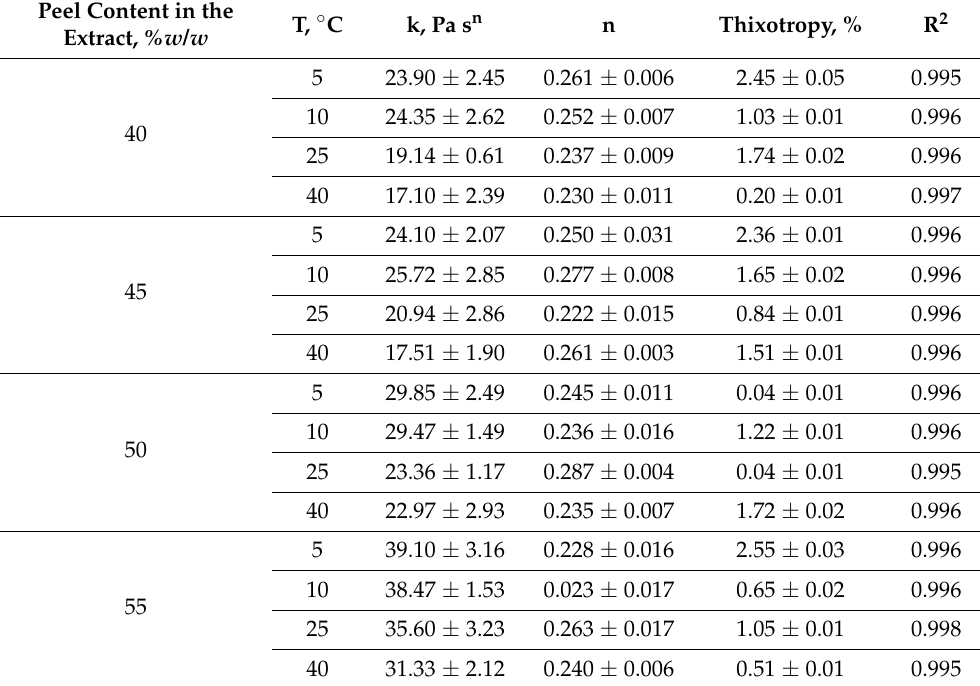
Table 1. Oswald–De Waele model rheological parameters (k and n) of passion fruit peel extracts. Peel Content in the T, ◦ C k, Pa s n Extract, %w/w